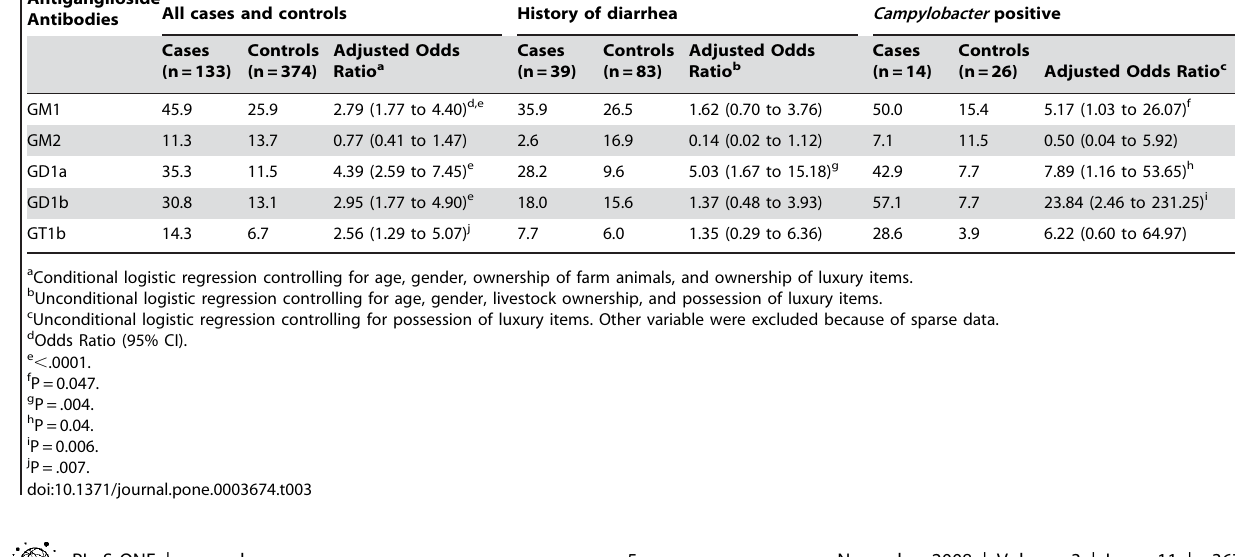
Antiganglioside Antibodies All cases and controls History of diarrhea Campylobacter positive Cases Controls Adjusted Odds (n=133) (n=374) Ratio a